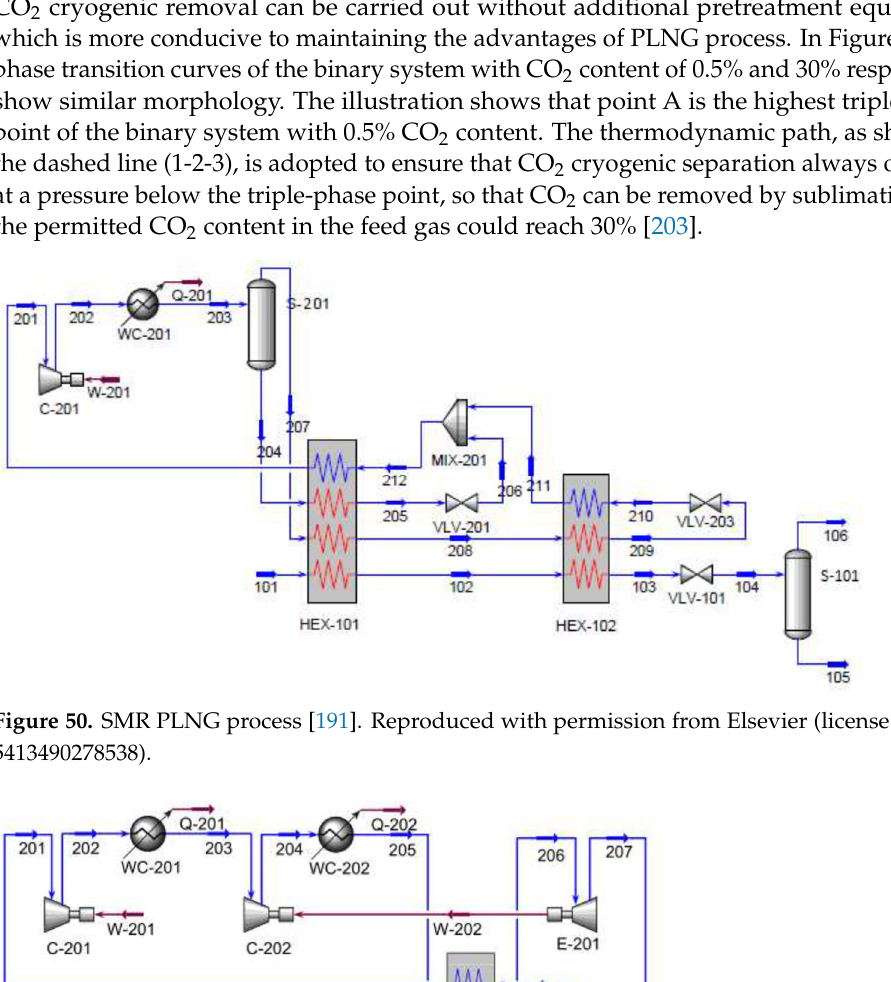
Figure 51. Single expander PLNG process [191].